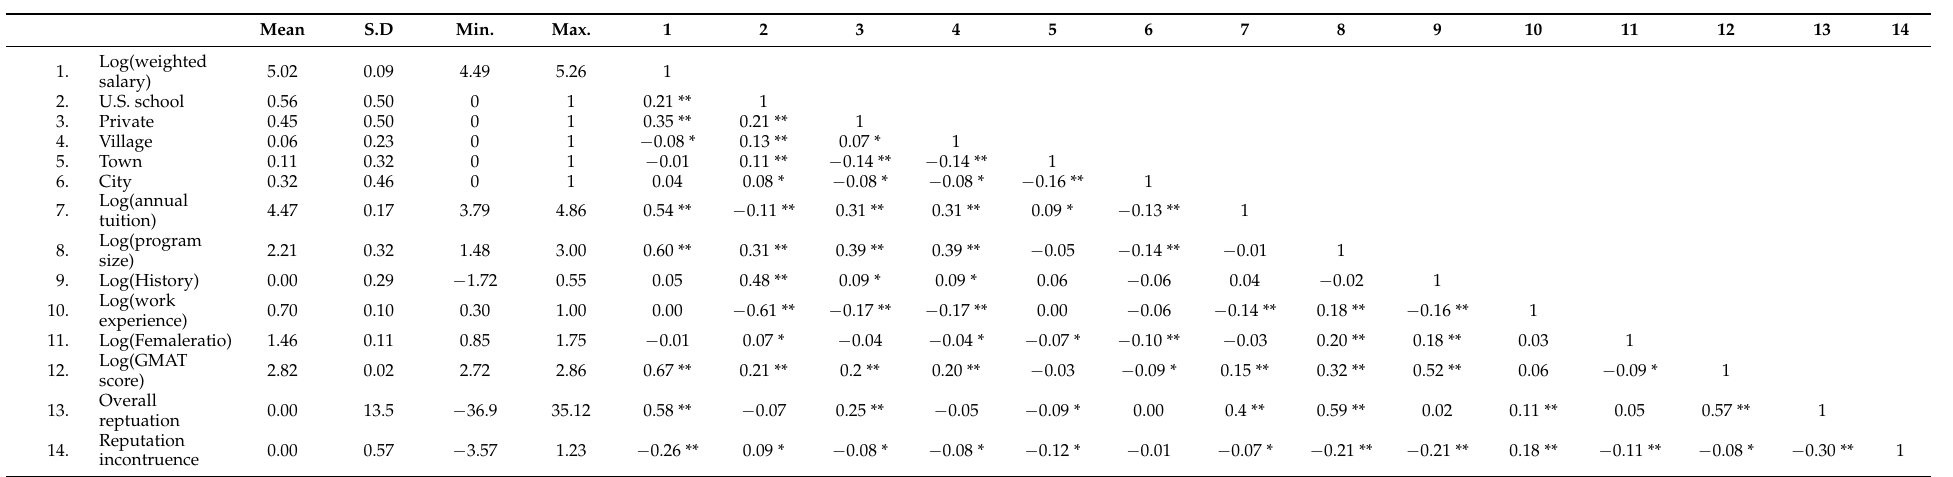
Table 3. Descriptive statistics and correlation coefficient in the models for recruiters (N =